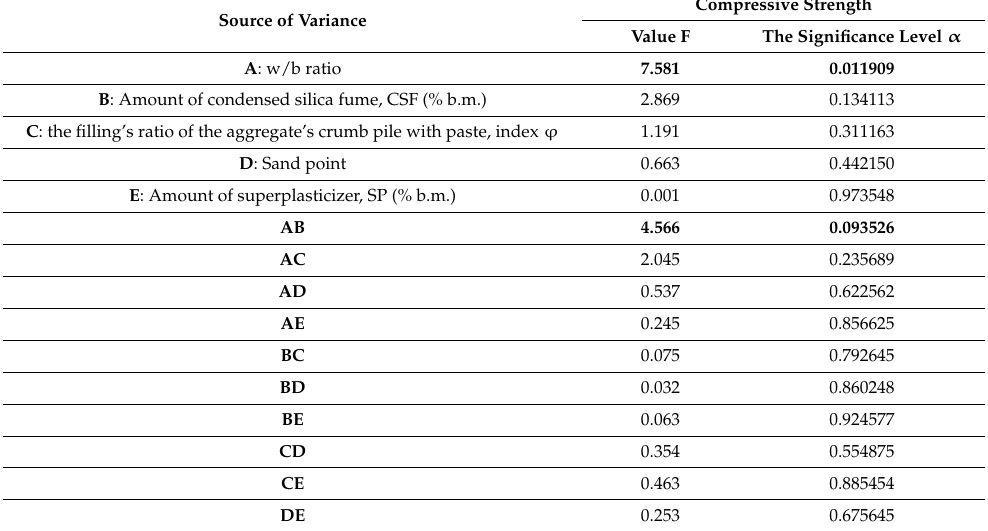
Table 9. Analysis of variance in testing variable